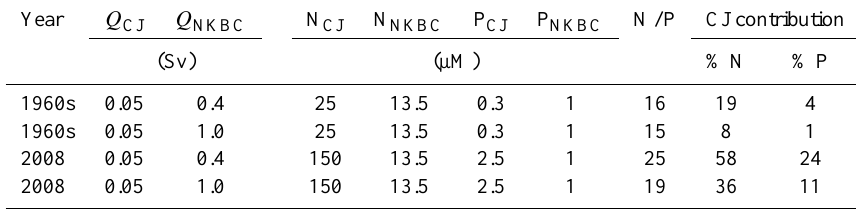
Note: Q CJ , runoff of Changjiang (CJ); Q NKBC , transport of the Nearshore Kuroshio Branch Current (NKBC); N CJ , DIN for CJ; N NKBC , DIN for NKBC; P CJ , phosphate for CJ; P NKBC , phosphate for NKBC.